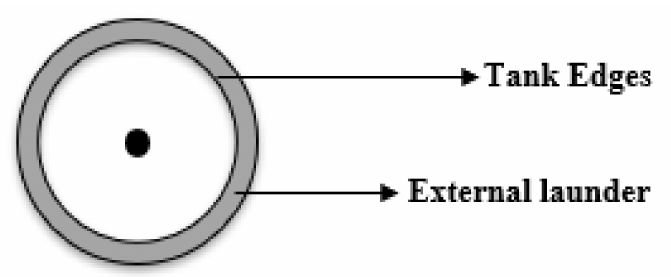
Figure 4. External launders [70].